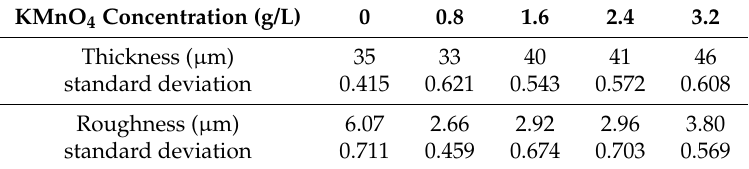
Table 1. Thickness and surface roughness of MAO coatings at different KMnO 4